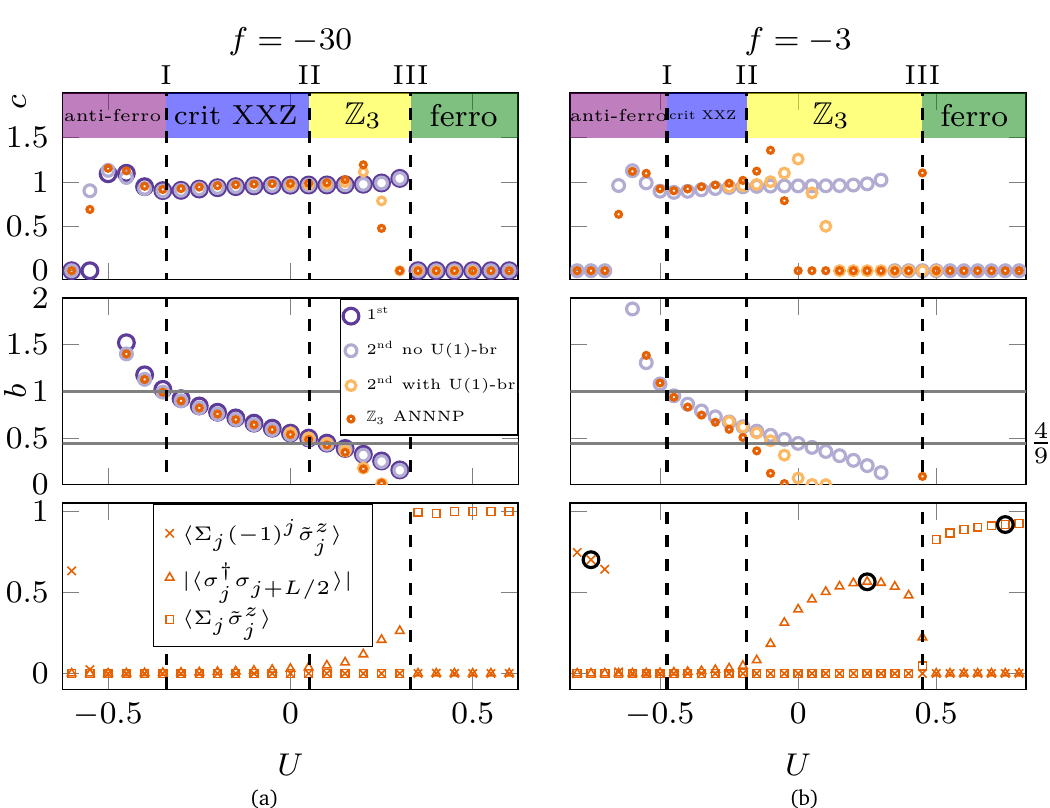
Figure 8: Numerical results for the different XXZ approximations (with and without the U(1)-breaking term) and the full (cid:90) -ANNNP model for L = 200 for (a) f = − 30 3 and (b) f = − 3. The top and middle panels show the central charge c and scaling exponent b , respectively; the solid horizontal lines at b = 1 and b = 4 / 9 indicate the values of the exponent belonging to transitions I and II. The bottom panels show the three order parameters introduced in (41), it will be discussed in Section 7.3. The black circles highlight the points for which further results are shown in Figure